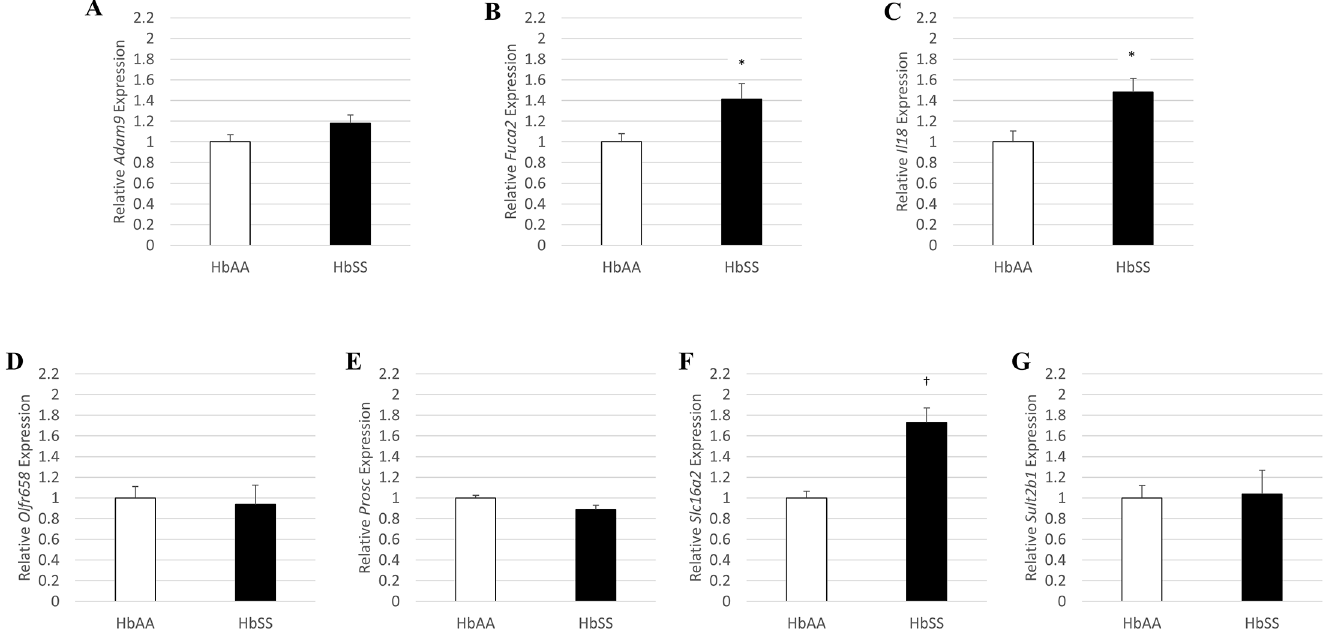
Fig 2. Comparison of candidate gene expression levels in myocardial tissue of mice with and without sickle cell disease. A: Adam9 , B: Fuca2 , C: Il18 , D: Olfr658 , E: Prosc , F: Slc16a2 , G: Sult2b1 . Error bars denote standard error of the mean. * (cid:2) 0.05; † (cid:2) 0.001.